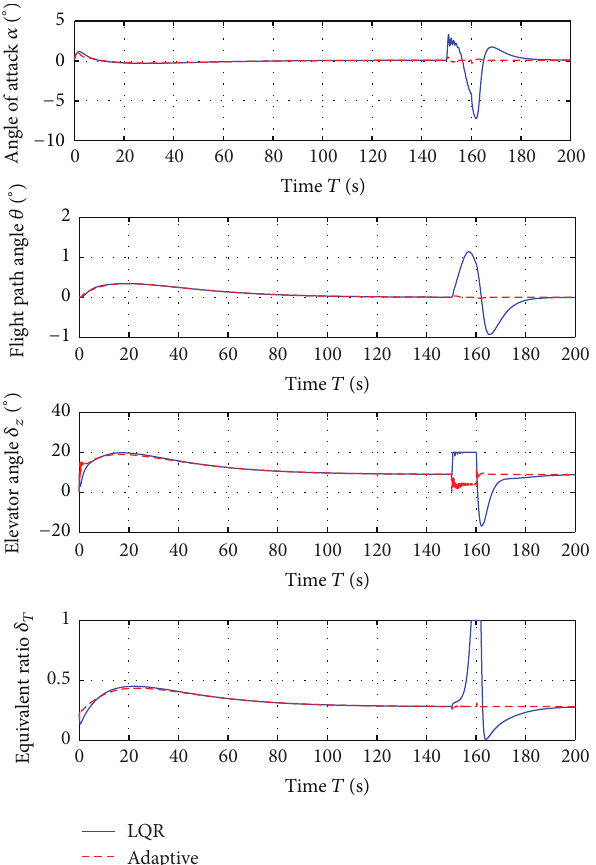
Figure 5: Attitude response curves with